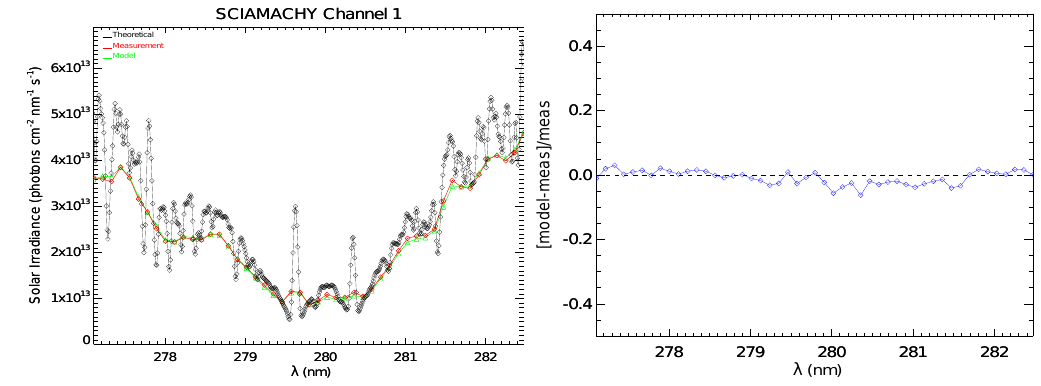
Figure 3. Example of a fitted solar line in Channel 1 ( left ). This is Line 1 from Table 3 and is measured in orbit 8884. SCIAMACHY measurement is shown in red, our model in green, and the theoretical very highly resolved one in black. The corresponding retrieved ISRF is a Hyperbolic function with a FWHM (cid:39) 0.24 nm. The fitting residuals ( right ) corresponding rms (cid:39) 0.023.